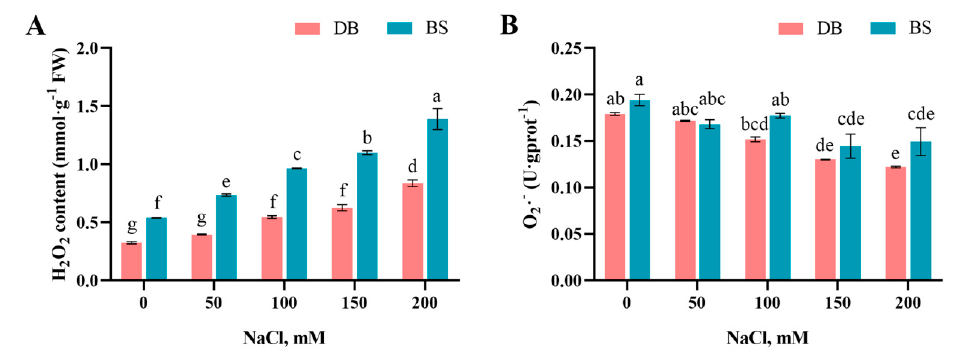
Figure 4. Effect of different NaCl concentrations on ( A ) hydrogen peroxide (H 2 O 2 ) content, ( B ) inhi- bition of O 2 · − product activity (O 2 · − ) of H. syriacus ‘Duede Brabaul’ (DB) and H. syriacus ‘Blueberry Smoothie’ (BS). According to Duncan’s test, different lowercase letters (a–g) indicate significant differences ( p < 0.05) between different treatments.